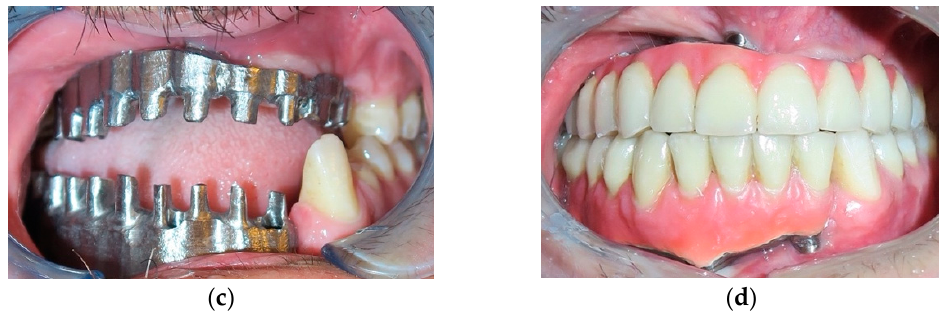
Figure 9. Intraoral view: ( a ) before prosthetic treatment; ( b ) temporary resin removable prosthesis; ( c ) a titanium base screwed on implants; ( d ) final implant supported prosthetic rehabilitation.